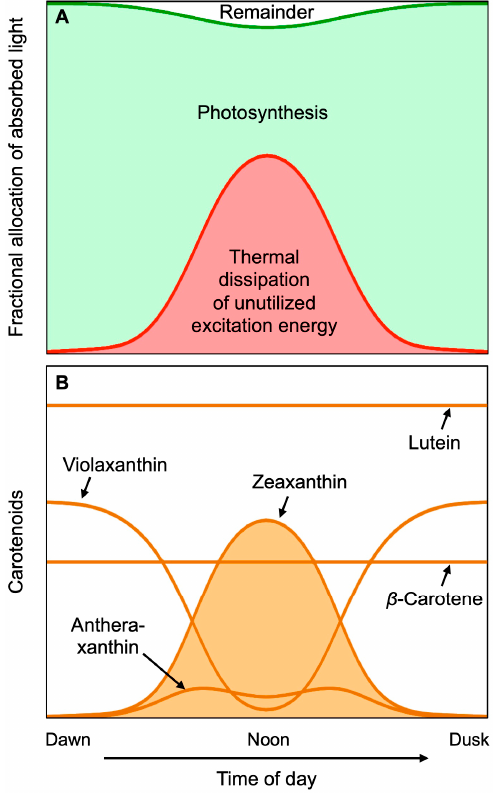
Figure 3. Schematic depiction of changes over the course of a clear day in ( A ) the fraction of light absorbed by a sun-exposed leaf that goes into photosynthesis (green), is dissipated harmlessly as heat (red), and is used by neither of the latter pathways (remainder; white). ( B ) shows corresponding changes in the level of the xanthophylls of the xanthophyll cycle, as well as the unchanged levels of lutein and β -carotene. Based on field data from evergreen shrubs reported in Adams et al. [18] and Demmig-Adams et al. [19]